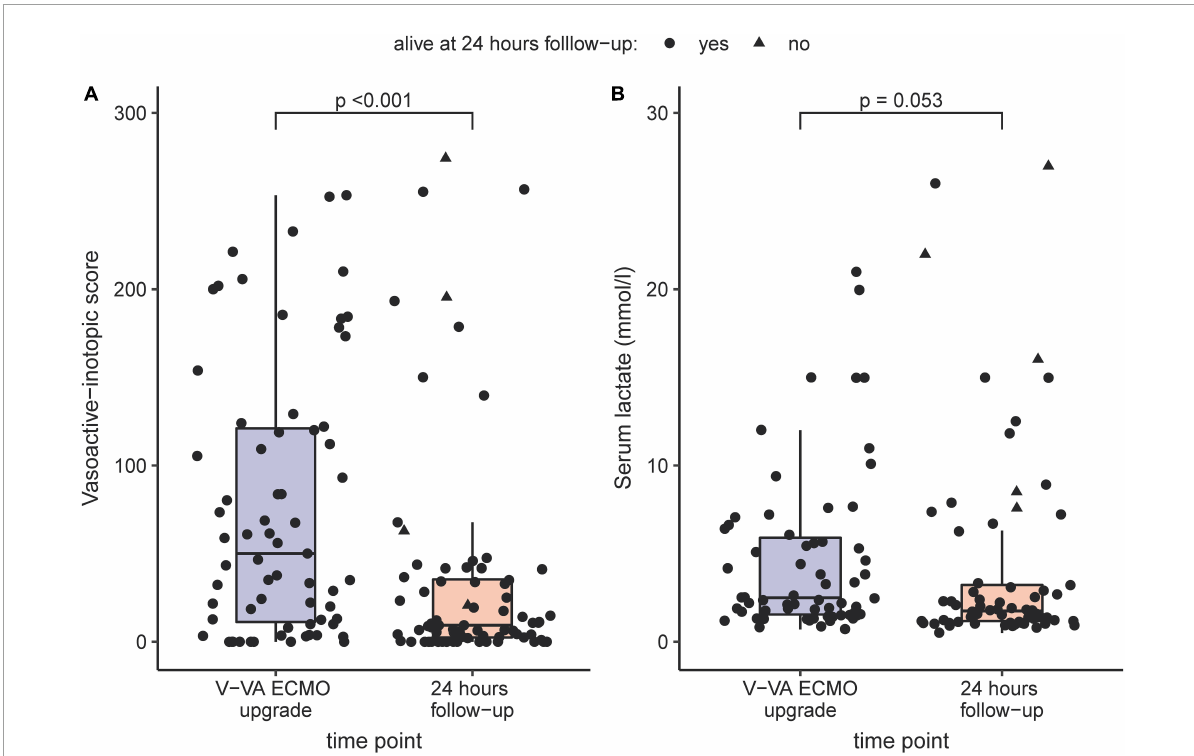
FIGURE1 Comparison of Vasoactive-inotropic score (A) and serum lactate (B) before V-VA ECMO upgrade and after 24 h under V-VA ECMO support visualized as boxplots and scatterplots. If patients deceased in the first 24 h, the latest value before discontinuation of life-sustaining therapies was